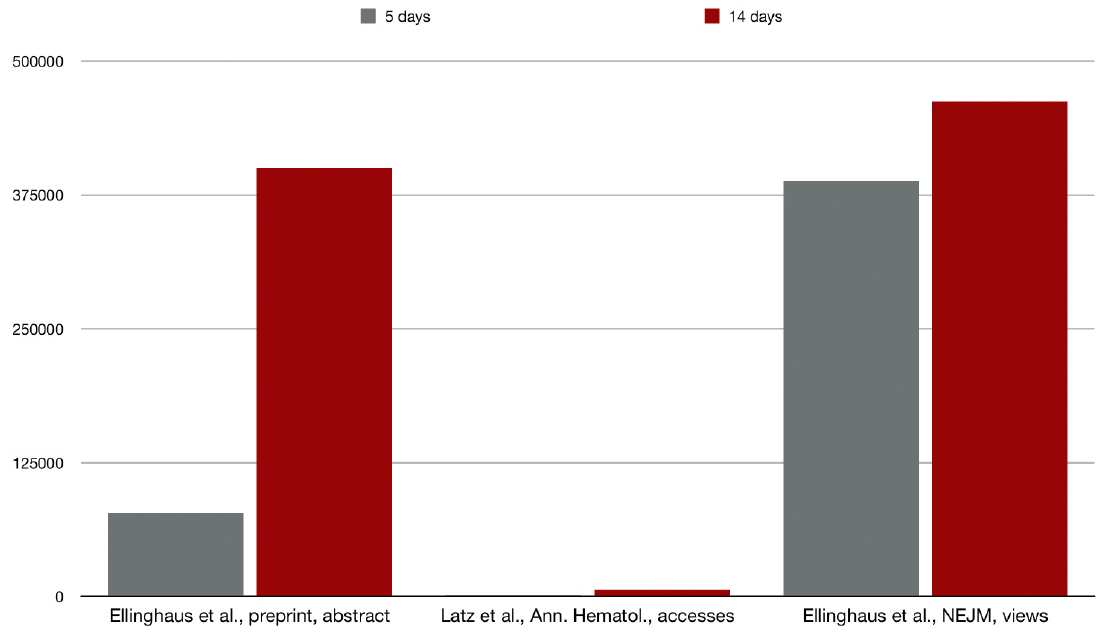
Figure 3. Article metrics for the preprint by Ellinghaus et al. 3 (number of abstract and preprint views), the Annals of Hematology paper by Latz et al. 5 (number of accesses), and the New England Journal of Medicine paper by Ellinghaus et al. 4 (number of views). Metrics for 5 and 14 days after publication are